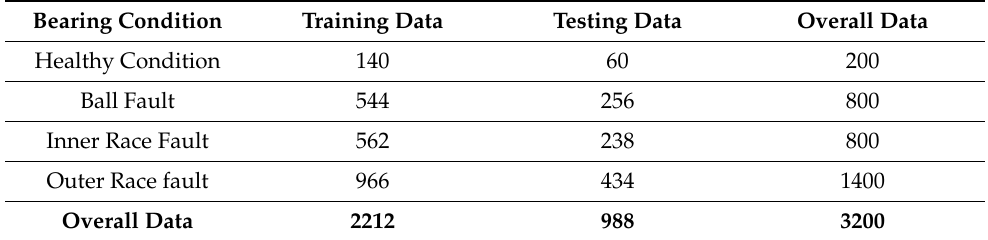
Table 2. Data split of overall data